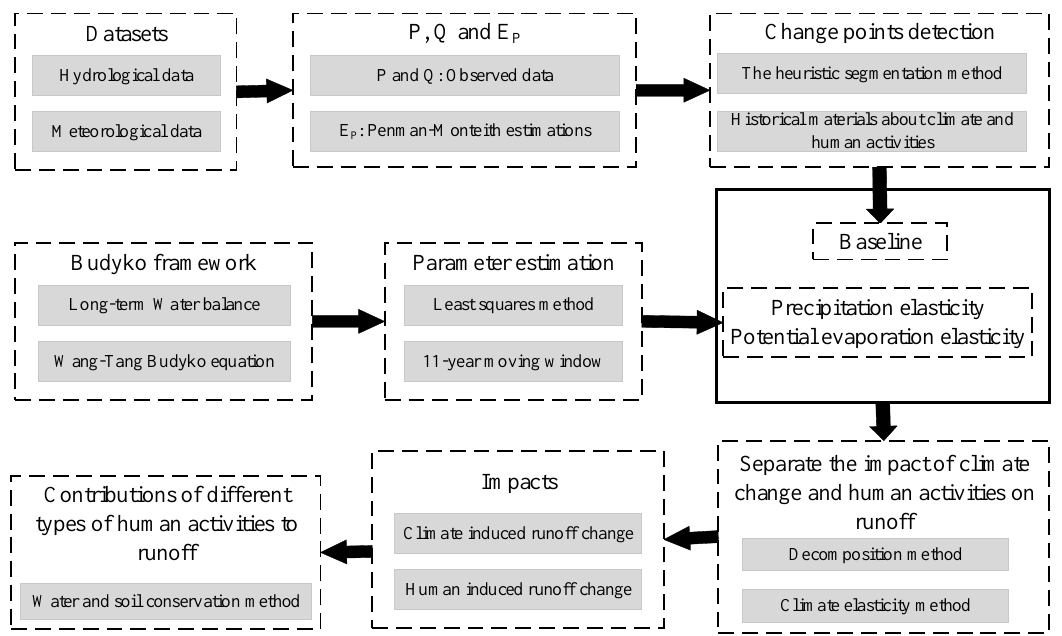
Figure 3. Flowchart of the framework for quantifying the impacts of climate change and human activities on streamflow change.